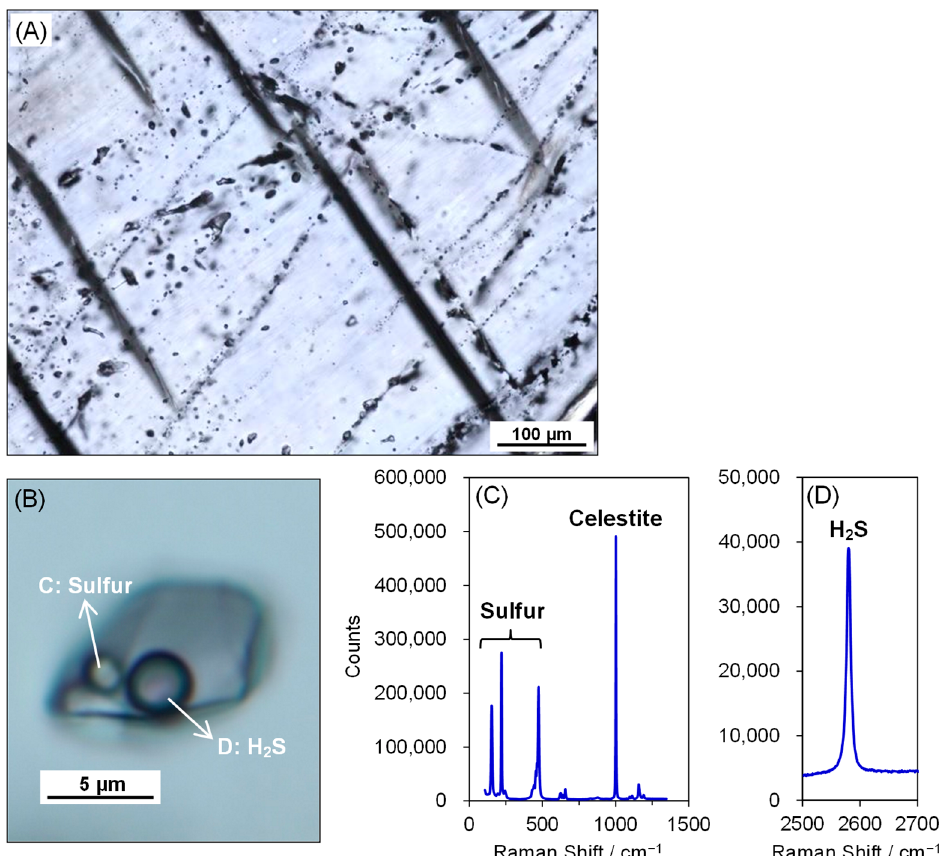
Figure 6. ( A ) Thin-section photomicrograph showing the fluid inclusions in celestite minerals of secondary origin, 6583.10m, P 3 c , YB2. ( B – D ) Microscopic laser Raman spectra analysis of fluid inclusions in celestite minerals, 6640.15 m, P 3 c , YB29.